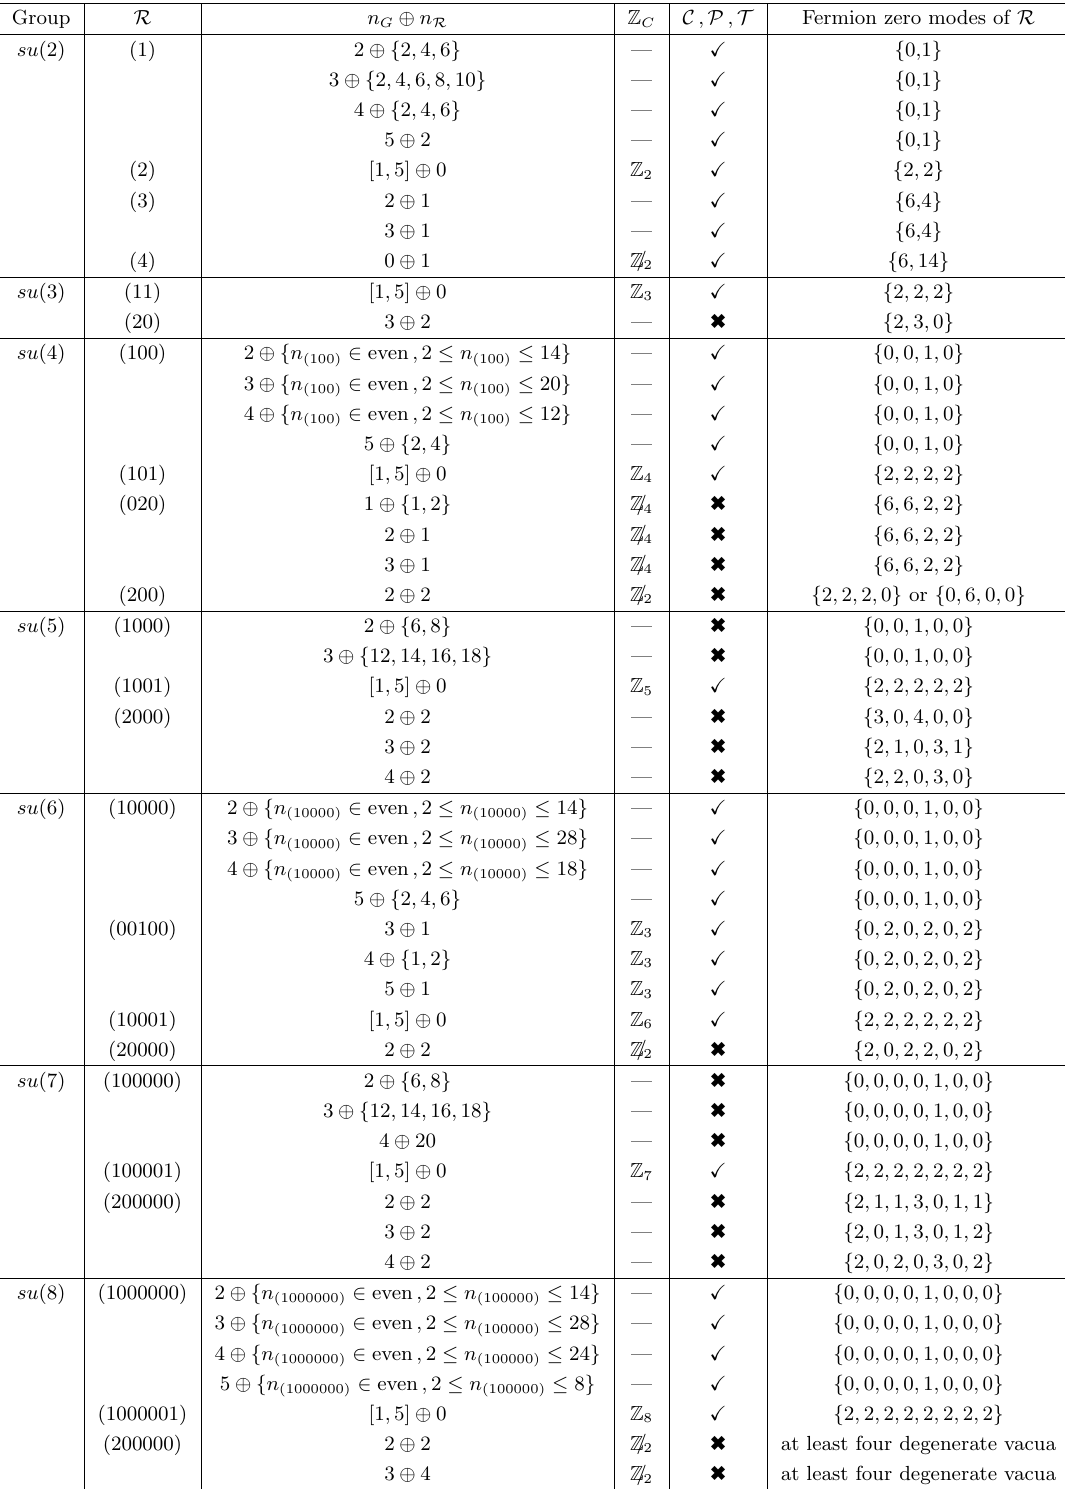
Table 8 . Summary of admissible